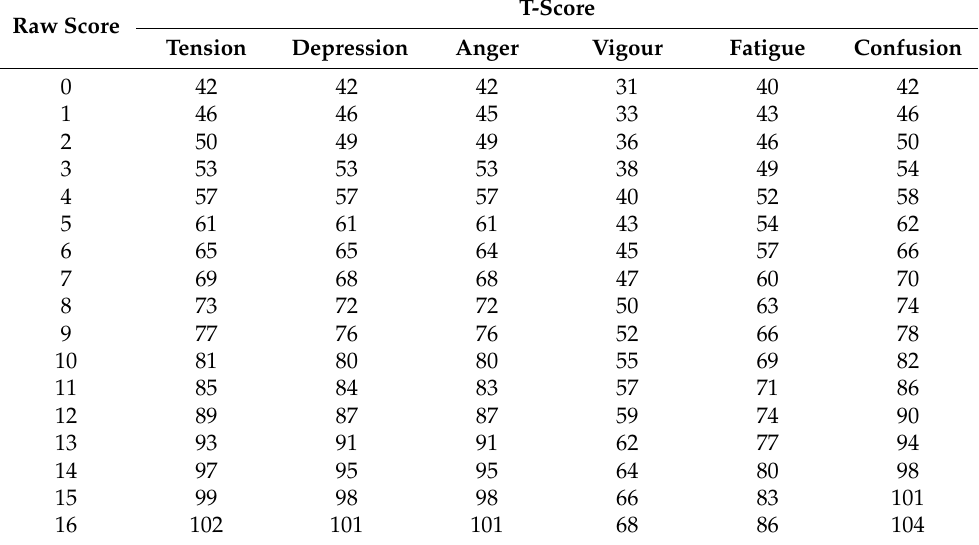
Table 6. MASMS normative scores for the female athlete sample ( n =